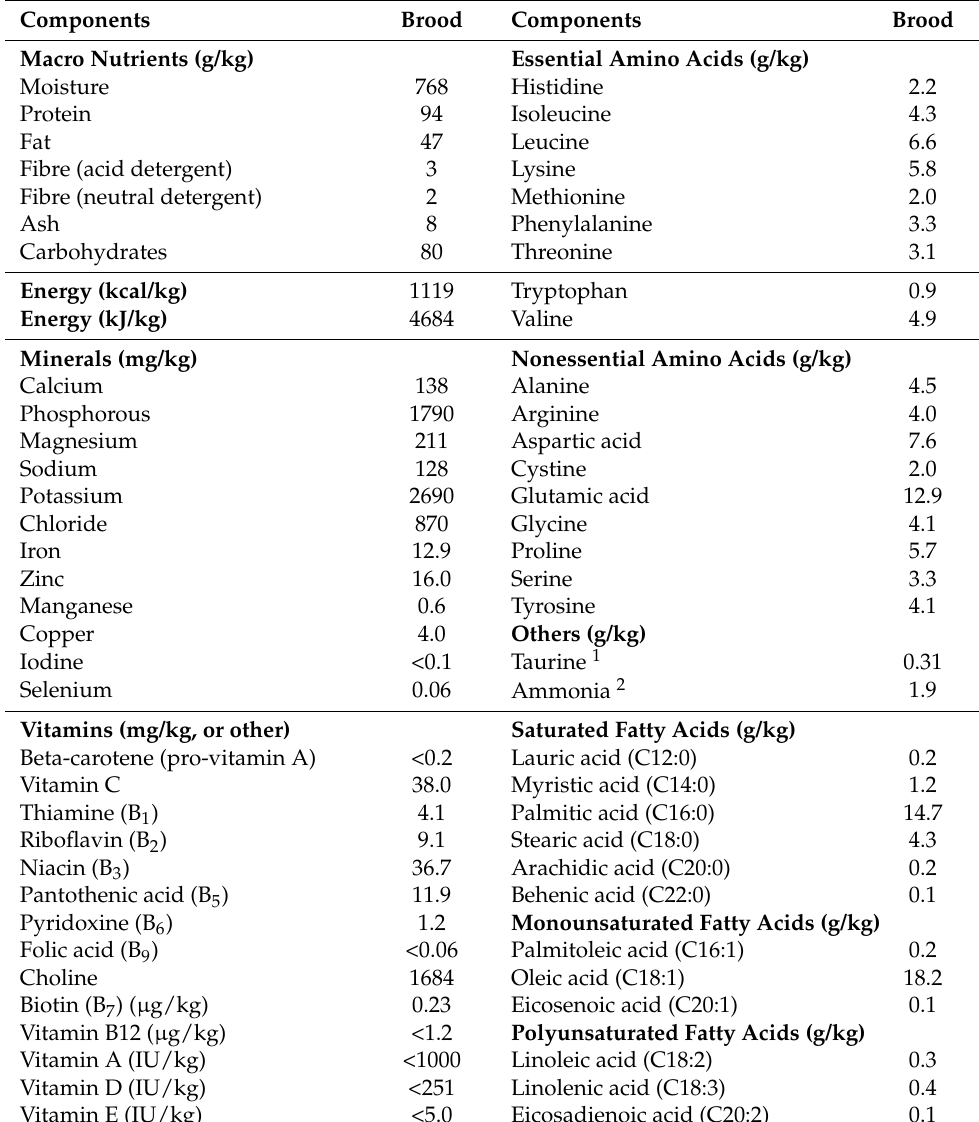
Table 1. Nutritional composition of honey bee broods